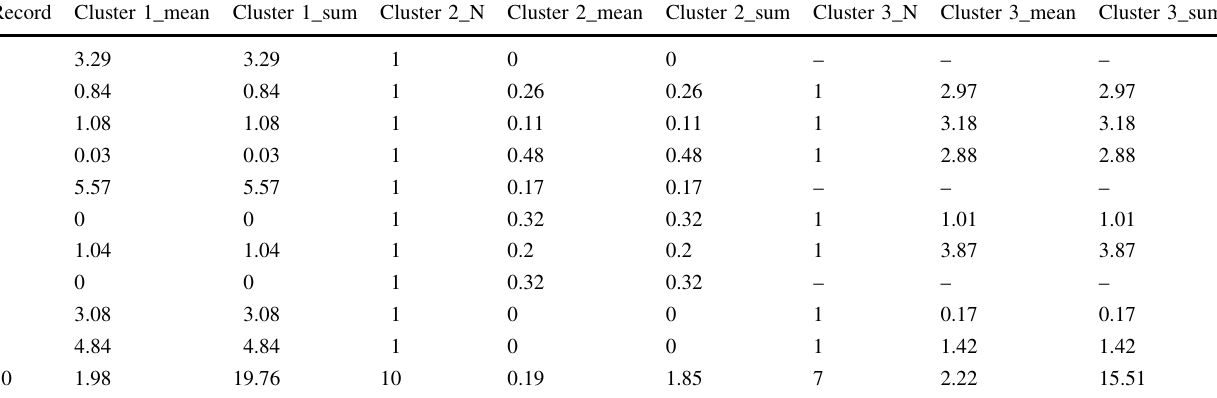
Table 1 Time (seconds) to first fixation based on three areas in Fig. 6. Cluster 1: green color AOI; cluster 2: yellow color AOI; cluster 3: red color